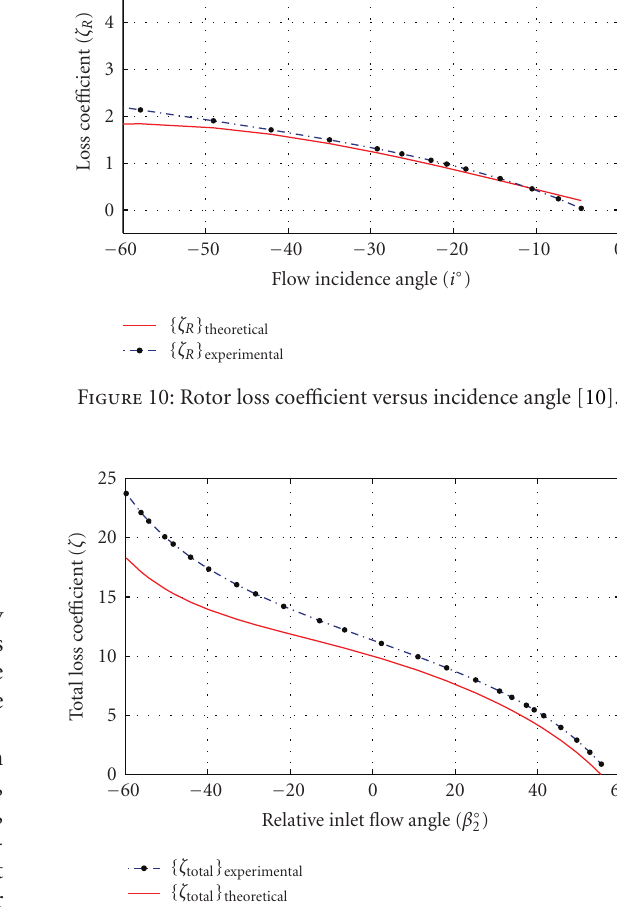
Figure 11: Turbine loss coe ffi cient versus inlet flow angle ( β 2 )